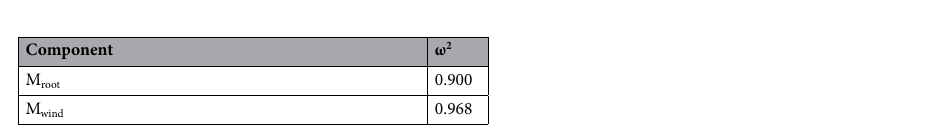
Figure 2. Variation trend of root anti-lodging index components during whole growth period in maize. Values in the same column followed by different lowercase letters are significantly different at the p < 0.05 level.